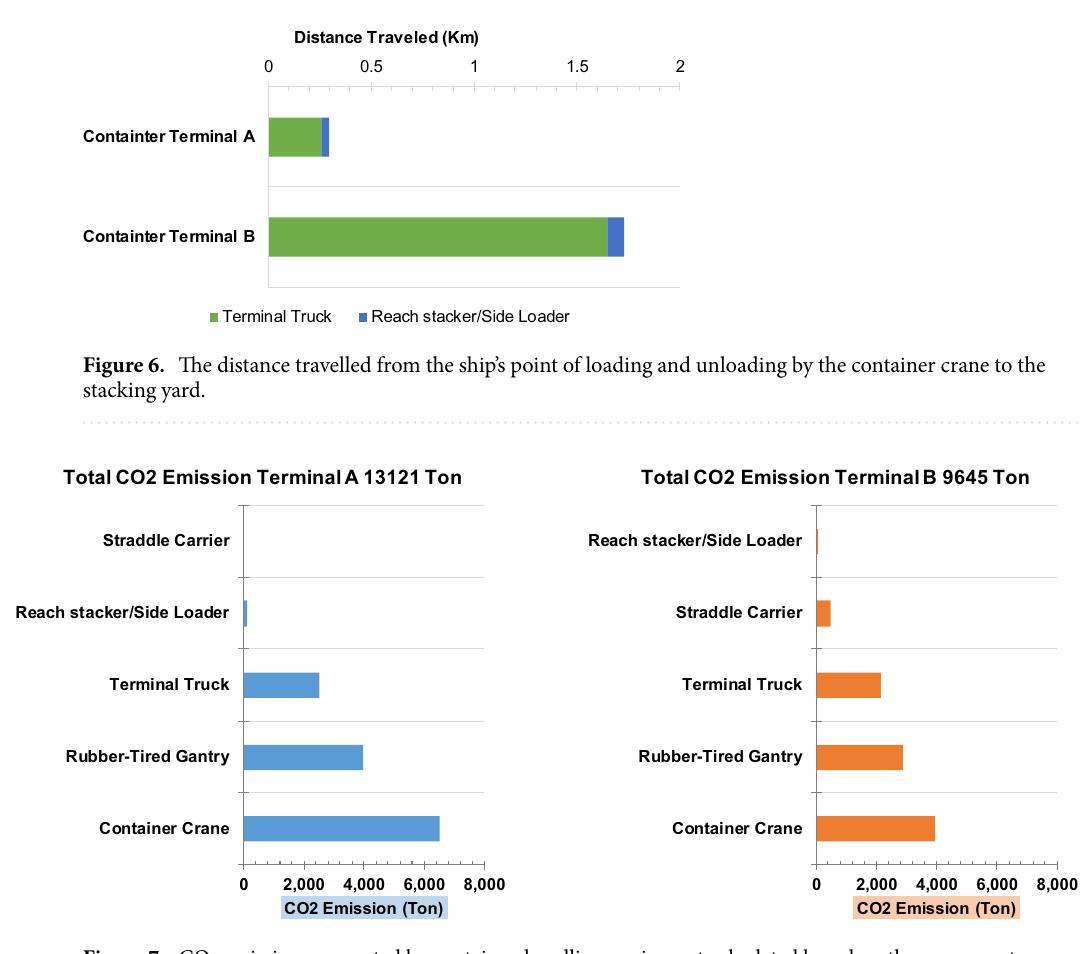
Figure 7. CO 2 emissions generated by container-handling equipment calculated based on the movement